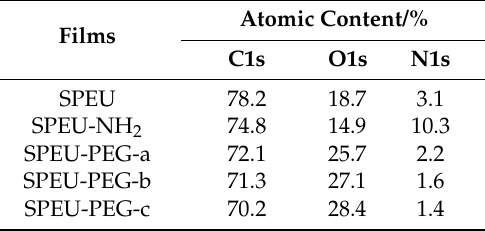
Figure 4. Overview XPS spectra of the SPEU, SPEU-NH 2 , and SPEU-PEG-a films. Table 1. Surface elemental composition of the SPEU, SPEU-NH 2 , and SPEU-PEG films by